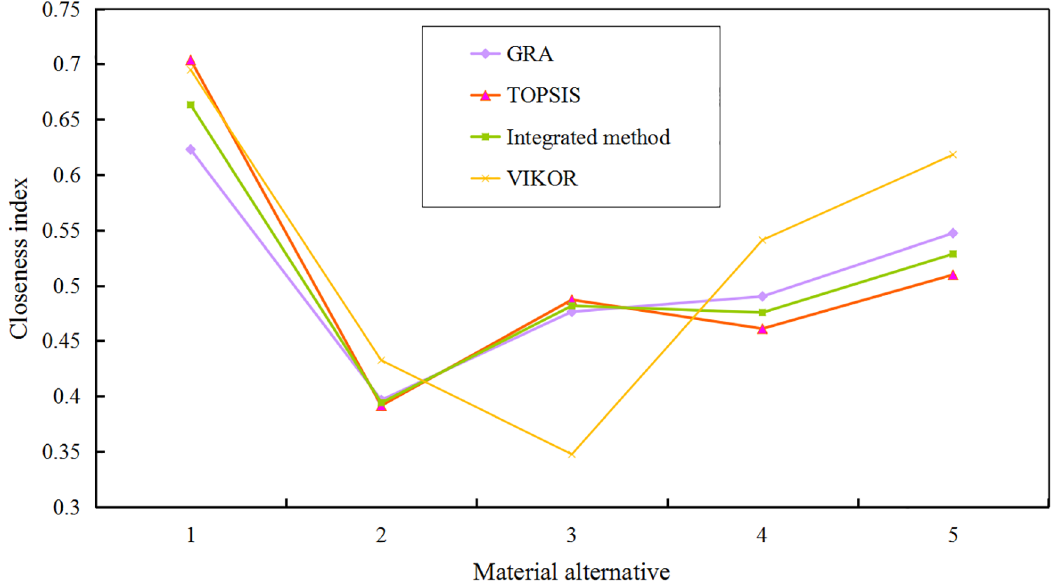
Fig 3. The closeness indices of the four